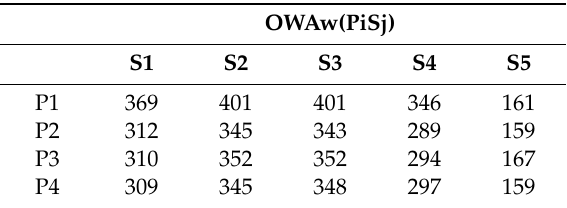
Table 3. Results of the ordered weighted averaging (OWA).